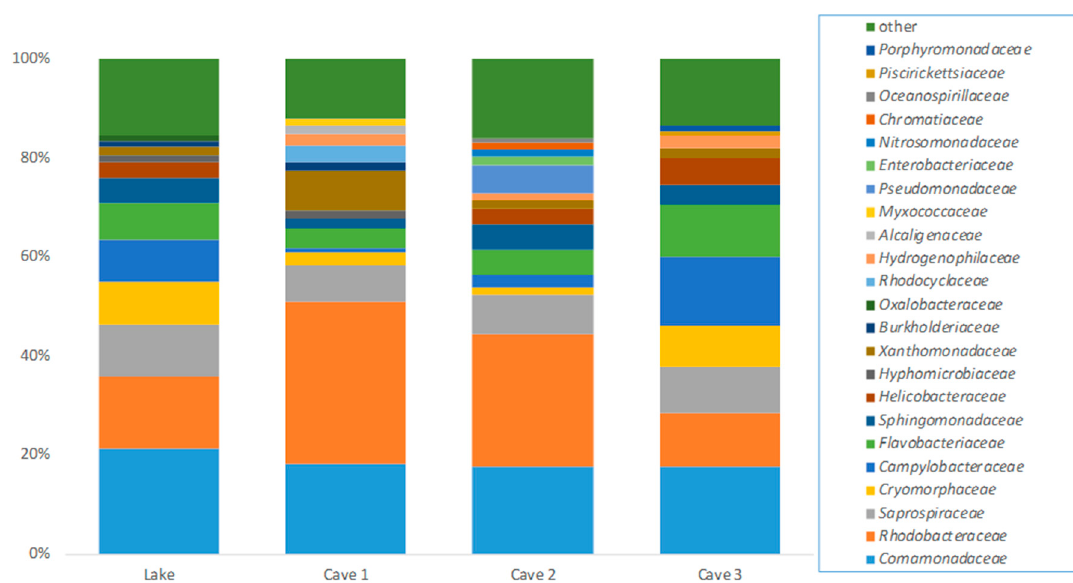
Figure 1. Abundance of families detected in thermal waters of Lake, Cave 1, Cave 2, and Cave 3 of the Kaiafas thermal spring Anigrides Nymphes in Greece. The term “other” represents the sum of the families with relative abundance <1%.